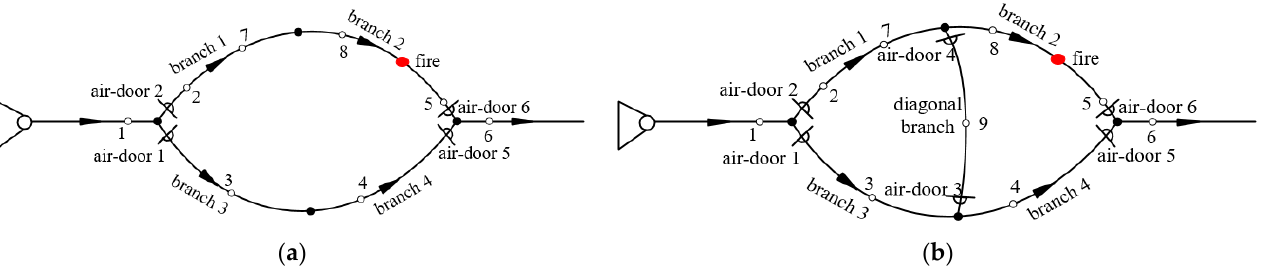
Figure 2. Schematic diagram of the experimental system after the air-doors regulation: ( a ) Ventilation network with parallel branches. ( b ) Ventilation network with a diagonal branch. Note: 1. Velocity, temperature; 2. Velocity, carbon dioxide, carbon monoxide, oxygen; 3. Velocity, temperature; 4. Velocity, temperature; 5. Velocity, carbon dioxide, carbon monoxide, oxygen; 6. Velocity, temperature; 7, 8. Temperature string; 9. Velocity, temperature, carbon dioxide, carbon monoxide, oxygen.